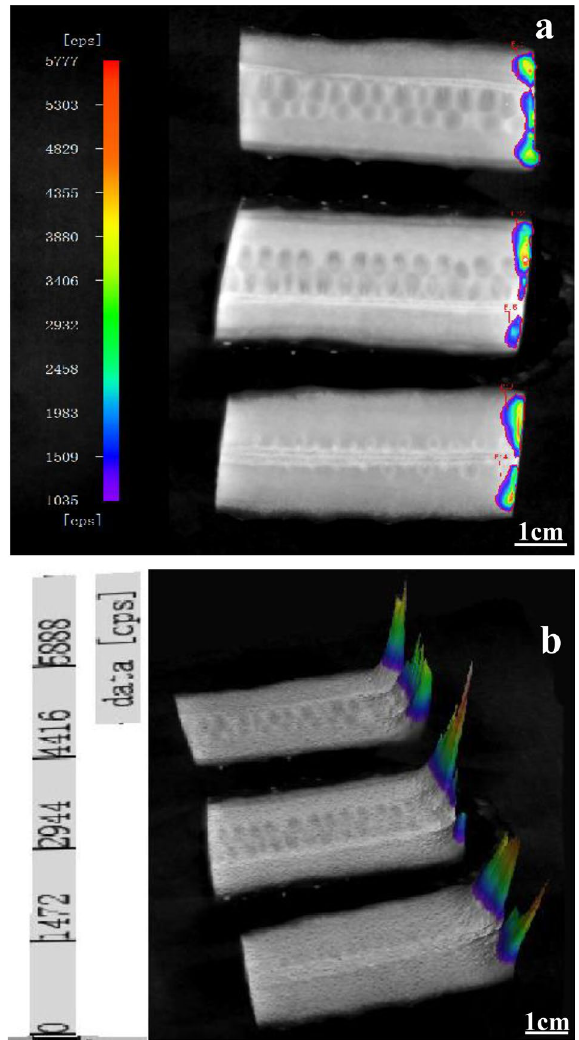
Figure 4. BL images of longitudinal section of E. coli internalized from the cross-section of cucumber. ( a ) Bacterial internalization image of cutting cucumber horizontally (cut surface of cucumber is on the right, 7.06 ± 0.25 log CFU/mL) with a bacterial knife and then cutting longitudinally. ( b ) The 3D surface chart of the same processed sample. The red color represented a strong signal and the blue color represented a weak signal. IndiGo software (https:// www. nchso ftware. com/ accou nting/ index. html? kw= sage% 20soft ware & gclid= AIaIQ obChM I3MvFj- zr7wI Vj2gq Ch14f AmLEA EYASA AEgJP qPD_ BwE, https:// softw areto pic. infor mer.